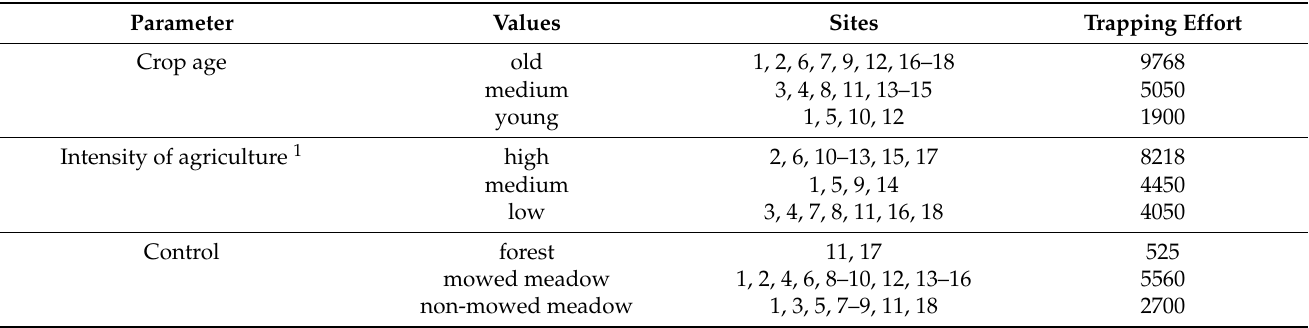
Figure 1. Location of the study sites in Lithuania with an indication of the crops (adapted from [42]). Table 1. Trapping effort in 2018–2020 according to crop age, intensity of agriculture, and control habitat type.